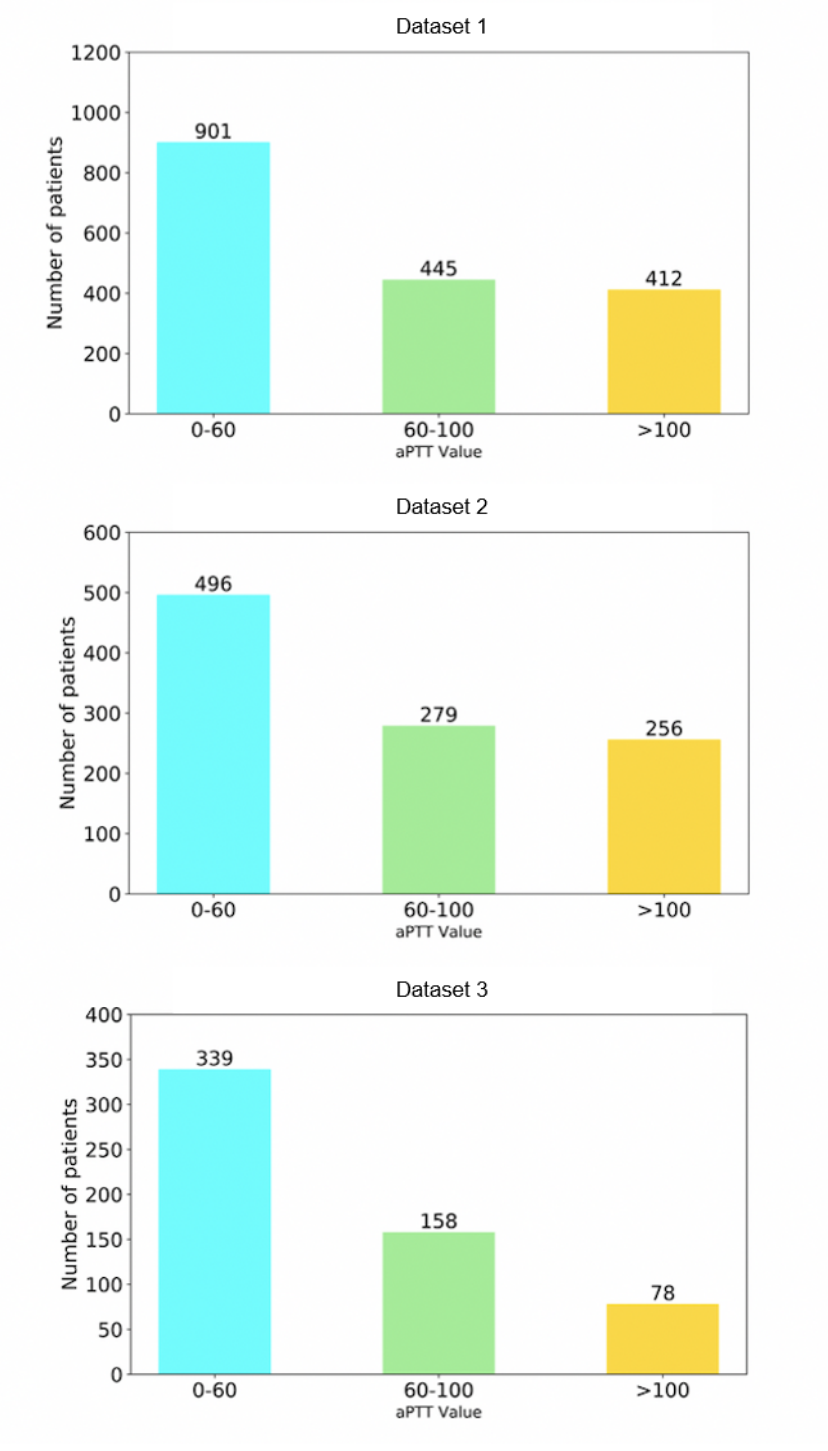
Figure 1. Patient distribution of aPPT value after initial heparin